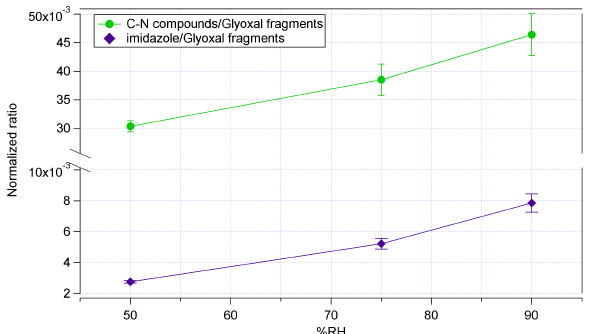
Fig. 5. The ratio of the total C-N compounds to glyoxal fragments (green diamonds) and the imidazoles to glyoxal fragments (purple diamonds) for the reaction of AS 300nm particles with glyoxal gas at the measured RH values is presented. Both ratios show an in- crease with increasing RH value and decreasing total mass, since the mass of the glyoxal fragments decreases more drastically with increasing RH than the total C-N compounds and imidazoles. All masses are normalized to sulfate